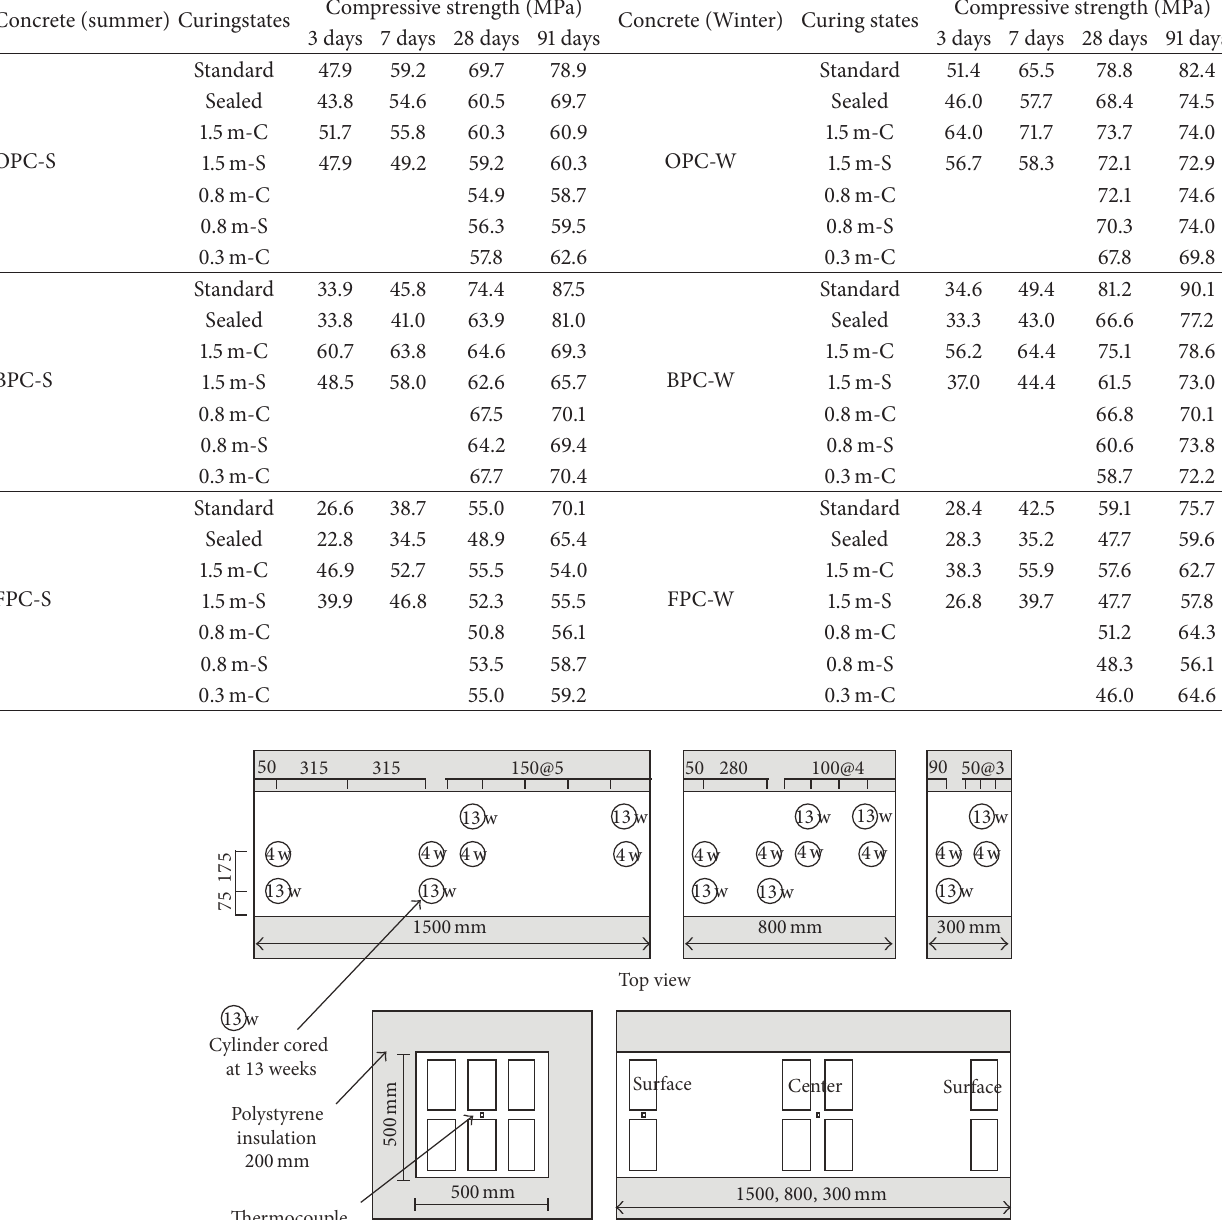
Table 4: Compressive strength data of concretes.